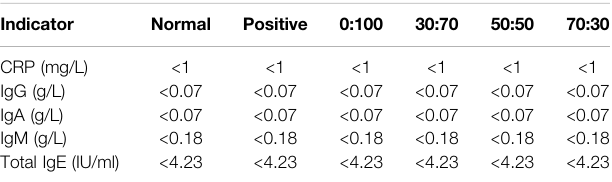
TABLE 3 | CRP and immunoglobulin levels in different groups 1 month after